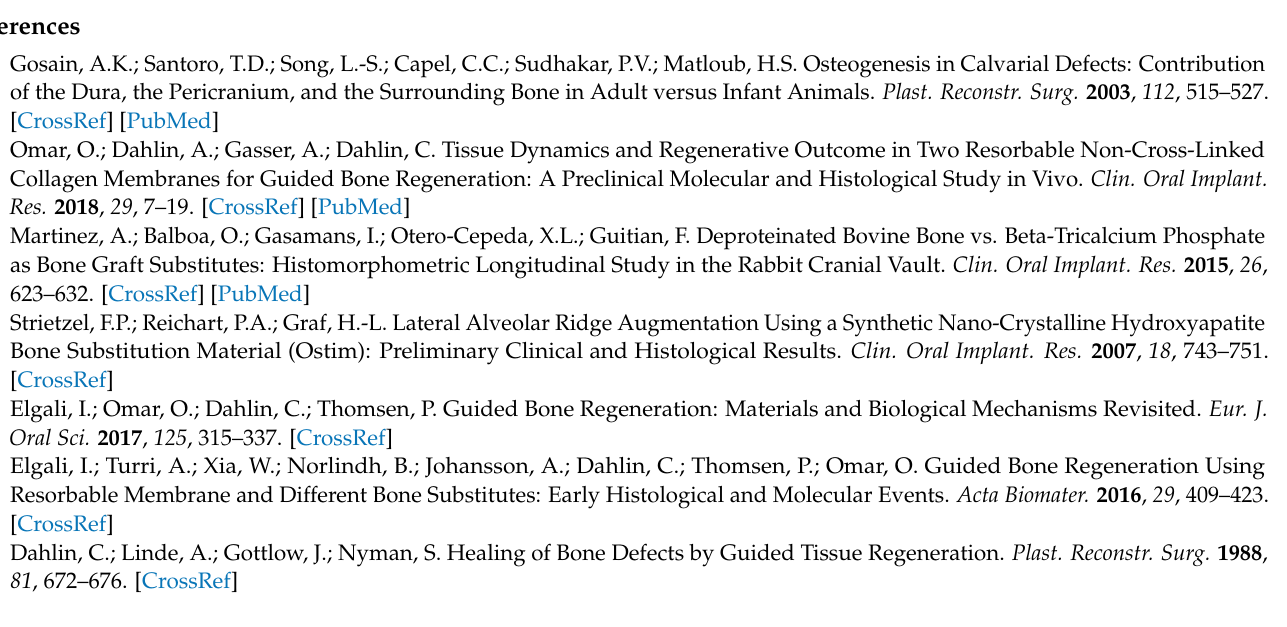
Table S3: Data from histomorphometric study of the new bone area, osteoid area, and soft tissue area fractions at each of the six regions of the grid, comparing the four groups of study; Table S4: Data from histomorphometric study of the new bone area, osteoid area, and soft tissue area fractions at each of the six regions of the